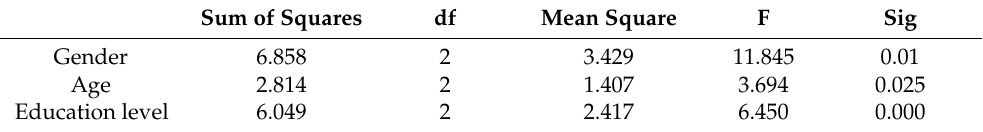
Figure 5. The photo with the lowest mean score (No.5). Table 7. ANOVA (Between Group).